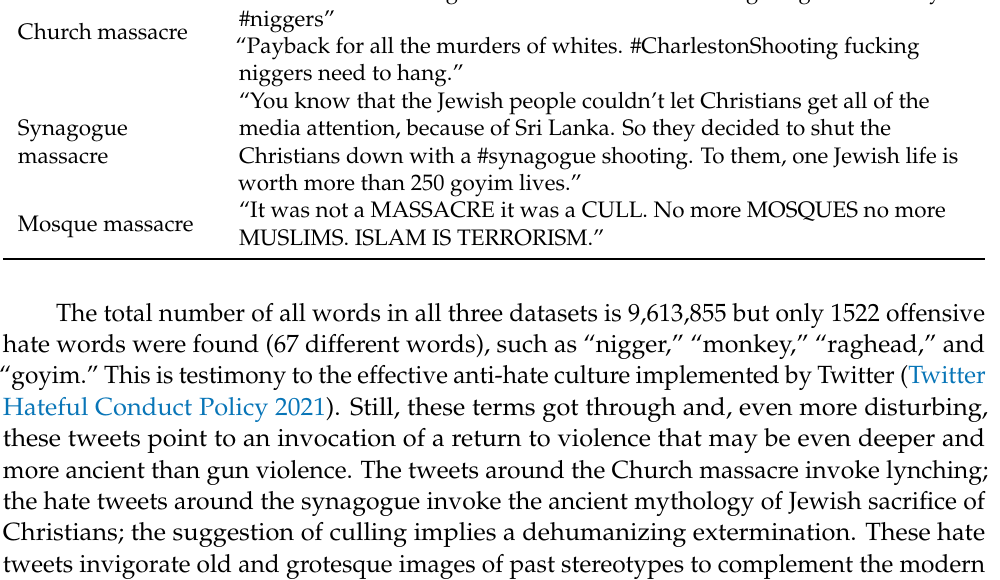
Church massacre